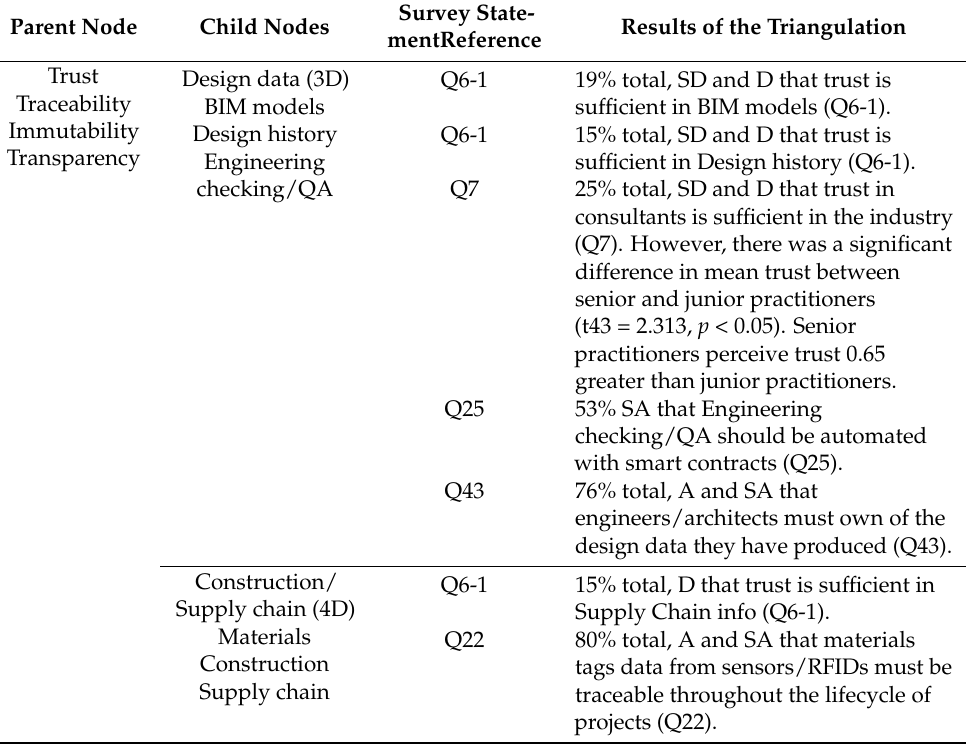
Table 14. Triangulation of the survey and interview outcomes in reference to parent nodes and child nodes from data analysis (interviews and